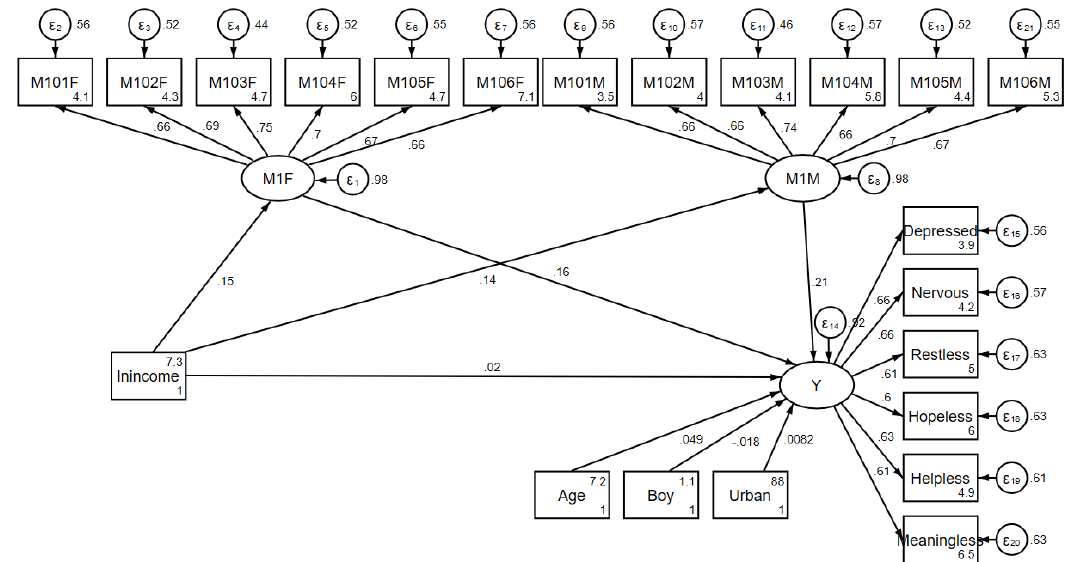
Figure 3. Structural equation model describing the mediation of parents’ emotional wellbeing.